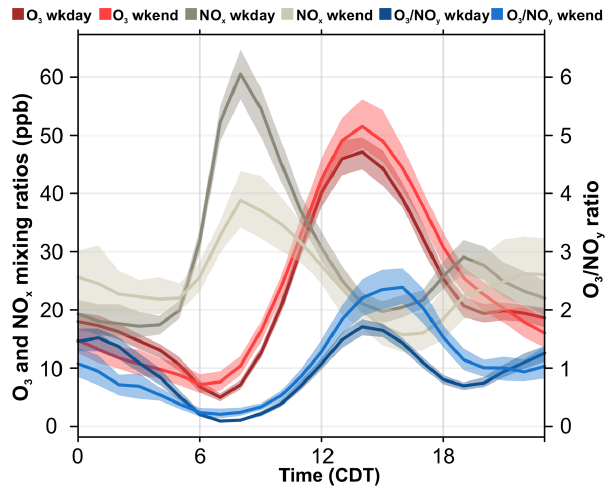
Figure 10. Average daily cycles for O 3 and NOx mixing ratios and O 3 /NO y ratios during weekdays and weekends from September 2012 to August 2013. The shading represents the 95% confidence intervals estimated through the bootstrap resampling. Table 6. Results of the ANOVA carried out for the average O 3 /NOy ratios calculated between 12:00 and 18:00 CDT at the OBI site during weekdays and weekends from September 2012 to August 2013.